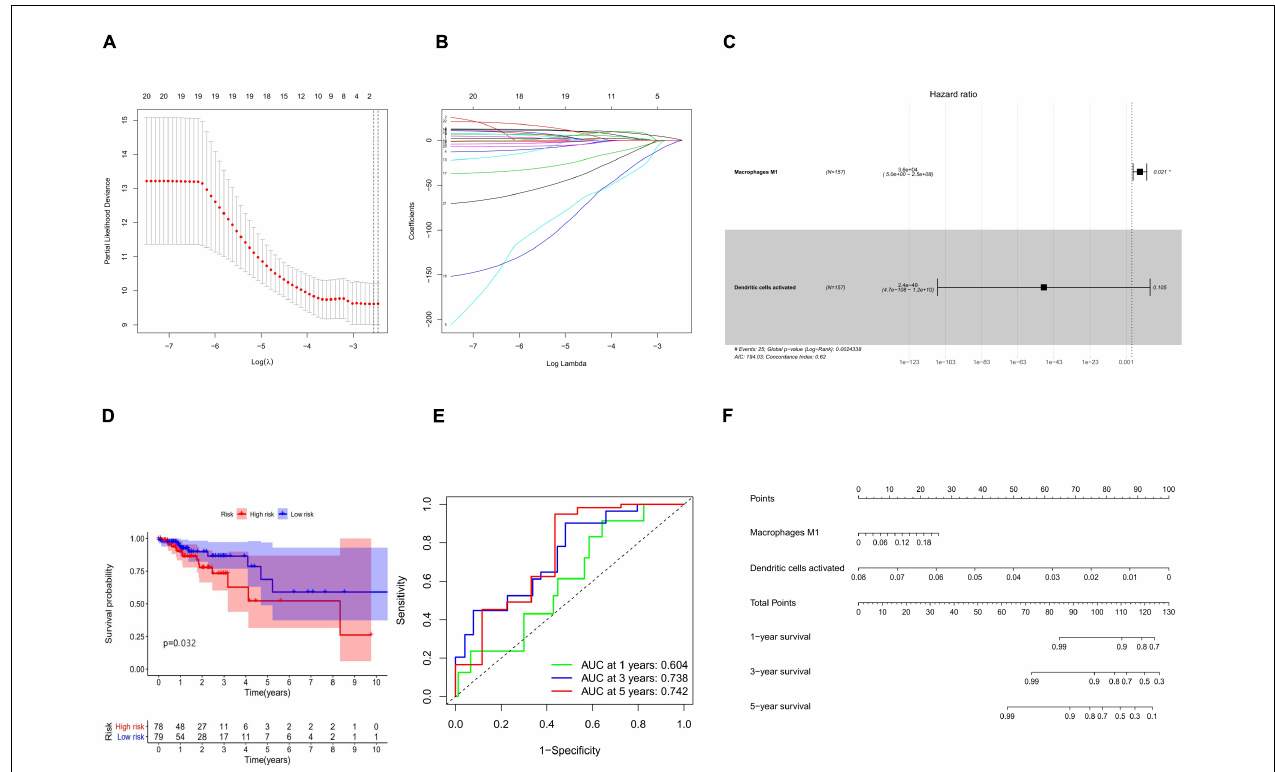
FIGURE 7 | (A) Lasso regression analysis to screen immune cells related to prognosis. (B) Calculating the risk score of each patient and establishing the risk model. (C) Cox regression analysis of two prognostic-related immune cells. (D) High and low risk of immune cell model comparison of the prognosis of patients in the group. (E) The evaluation efficiency of the risk model at 1, 3, and 5 years. (F) The visual display of the nomogram patient prognosis evaluation